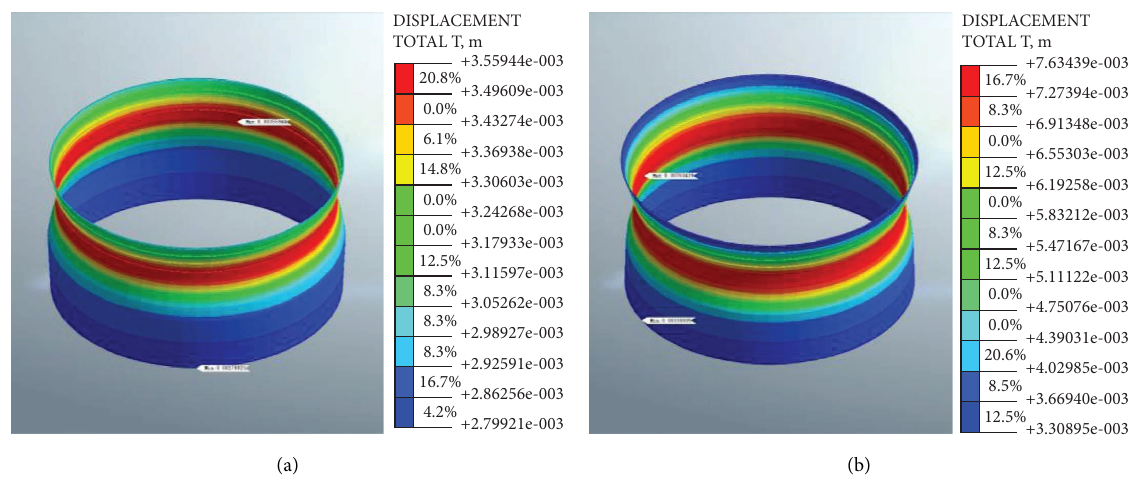
Figure 23: Working condition 5 wall deformation (a) without pore water pressure and (b) with pore water pressure applied.